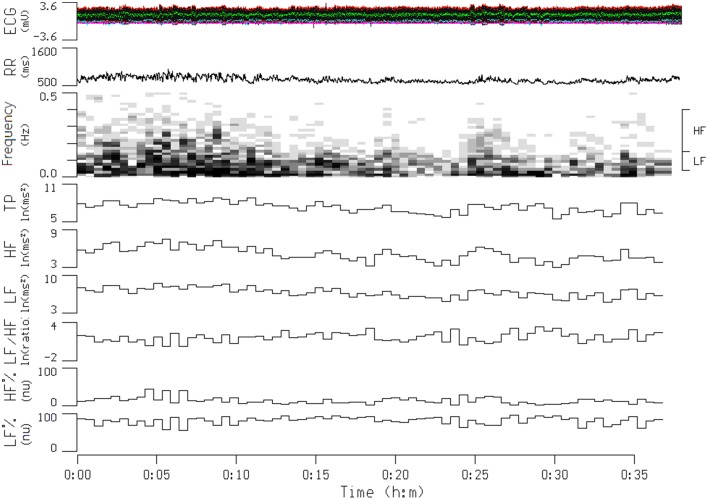
Continuous tracing of electrocardiogram (ECG), R-R interval (RR), and power spectrogram of a participant during a transition from a before smoking period to an after smoking period. The frequency ranges for the high-frequency (HF) and low-frequency (LF) components of RR signals are denoted on the right side of the spectrogram. Also shown are temporal displays of integrated values for the power density values of individual spectral components. This participant started to smoke at the 16-min time point, and the smoking process was finished at the 25-min time point. TP, total power; LF/HF, The ratio of low to high frequencies; HF%, HF in normalized unit; LF%, LF in normalized unit.